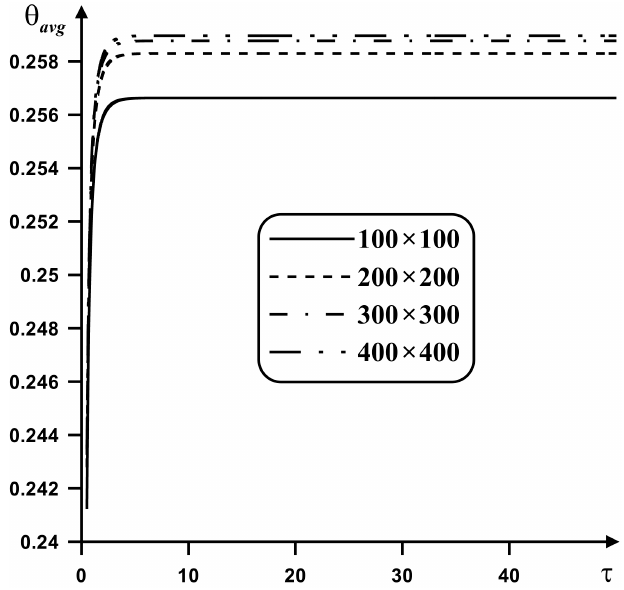
Figure 3. Mesh sensitivity analysis of average heater temperature for Pr = 7.0, Ra = 10 5 , ζ = 1, Da = 10 –2 , Os = 25, h = 0.2, δ = 0.12, n = 3, h 1 = 0.15.